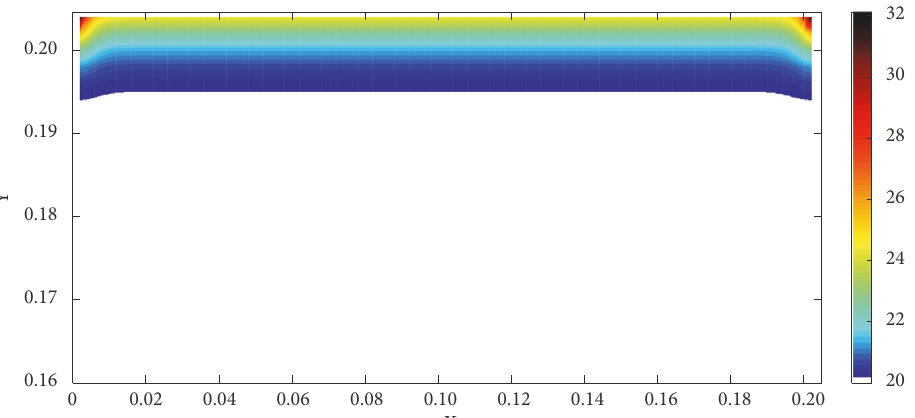
Figure 5: The temperature field in the t=100s.